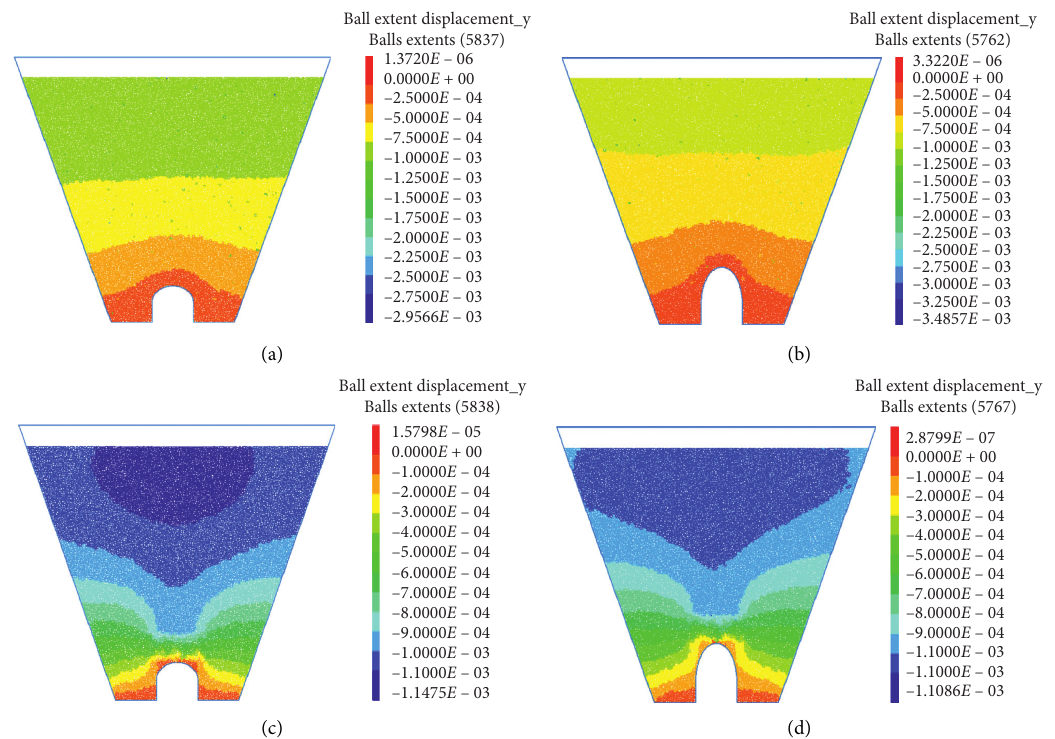
Figure 12: Variation of vertical displacement nephograms of soil particles for cases (a) S1, H/S � 0.4; (b) S1, H/S � 0.9; (c) S2, H/S � 0.4; (d) S2, H/S �